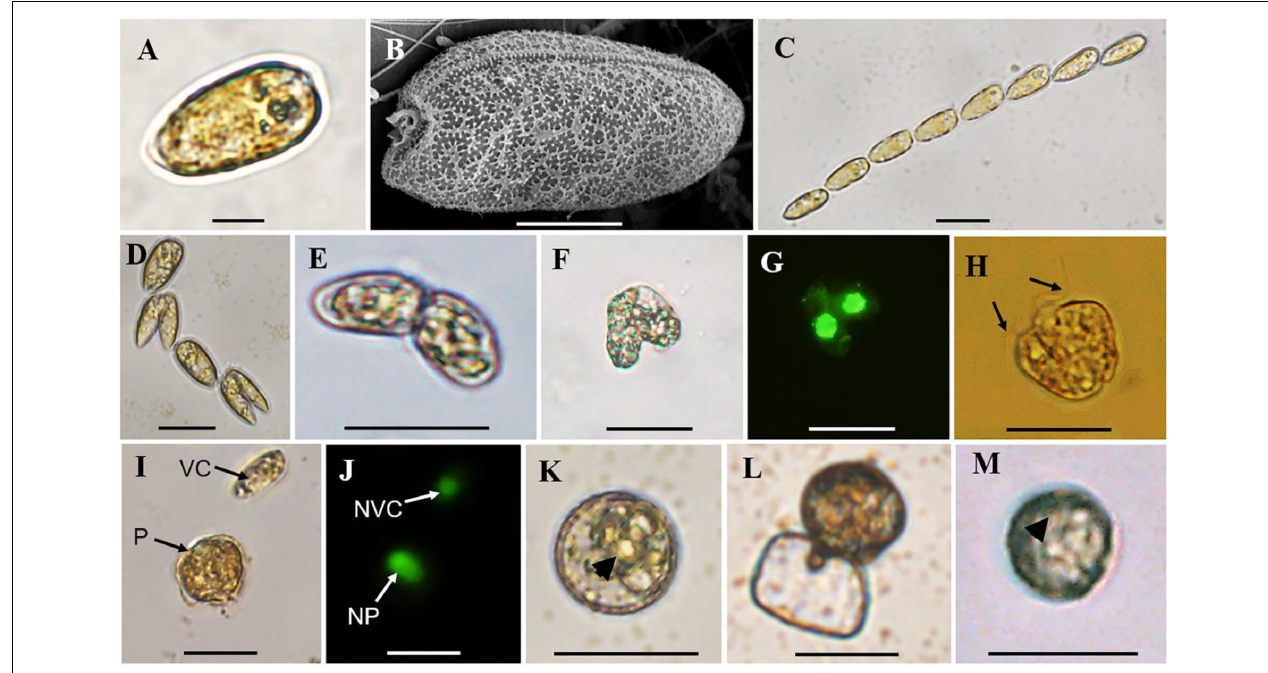
FIGURE 2 | Observations of vegetative cells of Prorocentrum donghaiense , cell chain, cells in division, cell pairs in mating, planozygote, resting cysts from culture and sediment. (A,B) Vegetative cell observed by light (LM) and scanning electron microscope (SEM); (C) a cell chain with eight vegetative cells observed by LM; (D) cells in division; (E) cell pairs in mating with two apical ends connected together observed by LM; (F,G) two mating cells in fusion observed by bright field LM and green epifluorescent LM for SYBR Green-induced green nuclear fluorescence; (H) planozygote with two similar flagella (black arrows) observed by LM; (I,J) a vegetative cell (VC) and planozygote (P) and their nuclei [nucleus of vegetative cell (NVC) and nucleus of planozygote (NP)] observed by bright field LM and green epifluorescent LM for SYBR Green-induced green nuclear fluorescence; (K) round and brown resting cyst from culture with thick wall and accumulation body (black arrowhead) observed by LM; (L) a new germling releasing from the archeopyle; (M) round and brown resting cyst detected from sediment with an accumulation body (black arrowhead) with LM. Scale bars for (A) = 10 µ m, (B) = 5 µ m, (C–M) = 20 µ